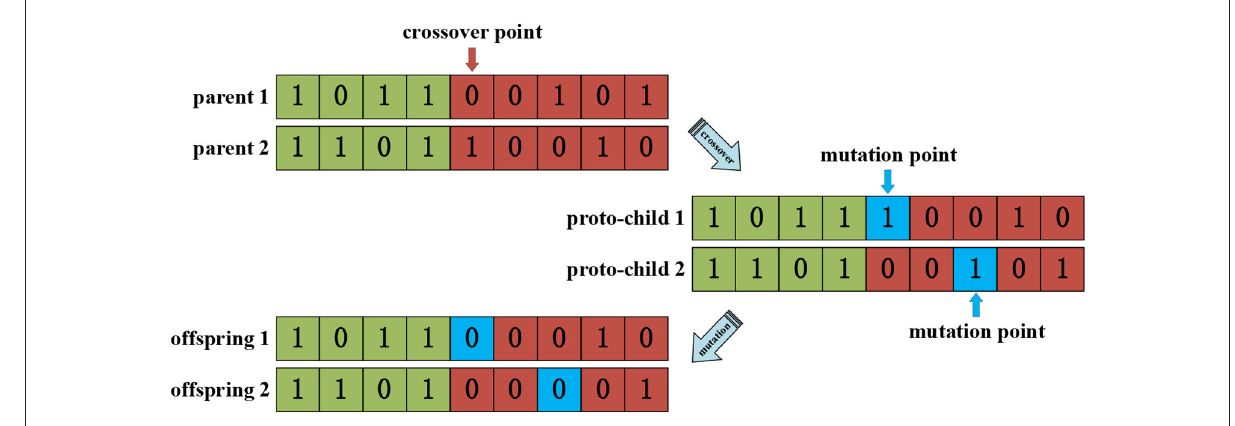
FIGURE7 Crossover and mutation processes using the genetic algorithm.